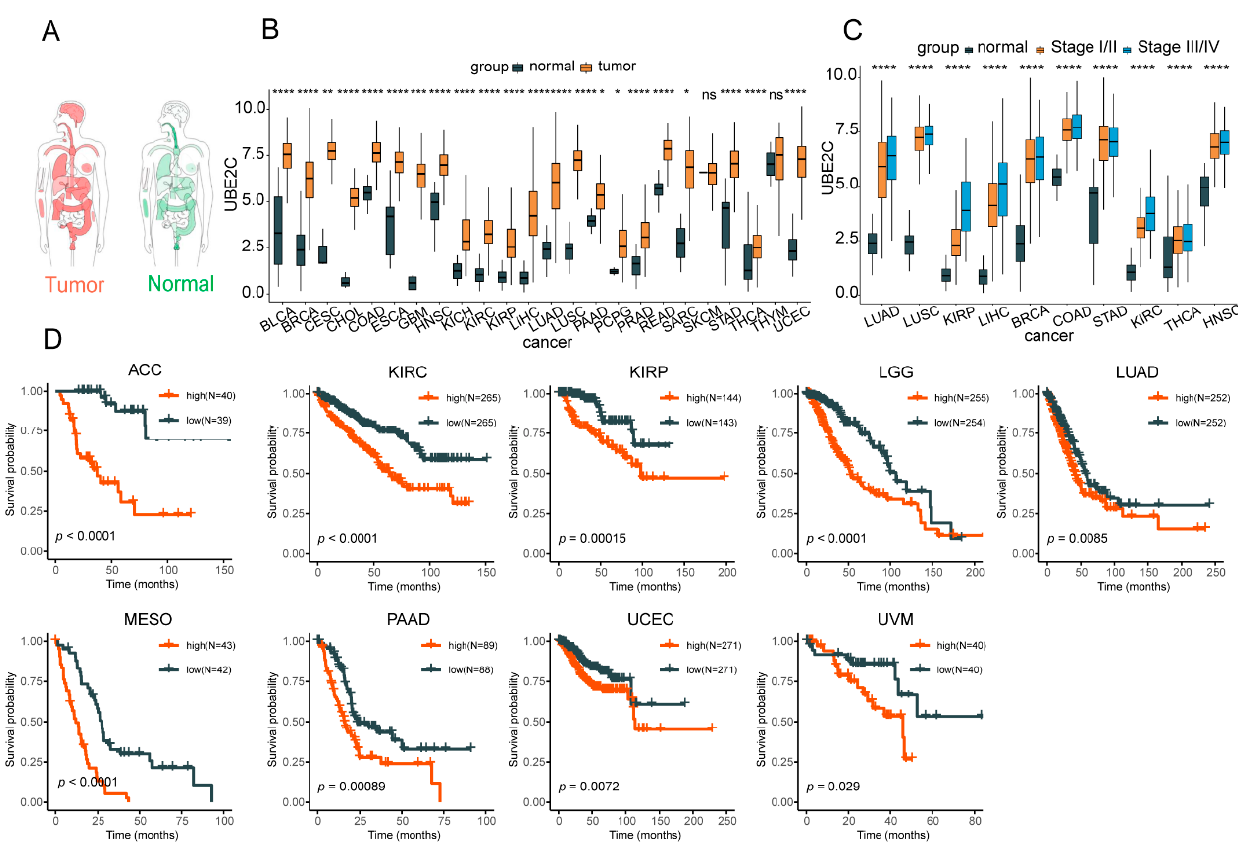
Figure 5. UBE2C significantly highly expresses in pan-cancer tissues and cells. ( A ) The expression profile of UBE2C in a normal person and patients. The darker the color, the higher the gene expression. ( B ) The expression level of UBE2C in TCGA pan-cancer tissues and their corresponding normal tissues. ( C ) The expression level of UBE2C in pathological stages of different cancer types. The statistical significance was analyzed by Student’s t -test (two-tailed) analysis. ( D ) The survival analysis of UBE2C in different cancer types. Kaplan–Meier survival analysis and the log-rank test were employed to compare OS between the tumor and normal cohorts. *: p < 0.05; **: p < 0.01; ***: p < 0.001; ****: p < 0.0001; ns: no significance.